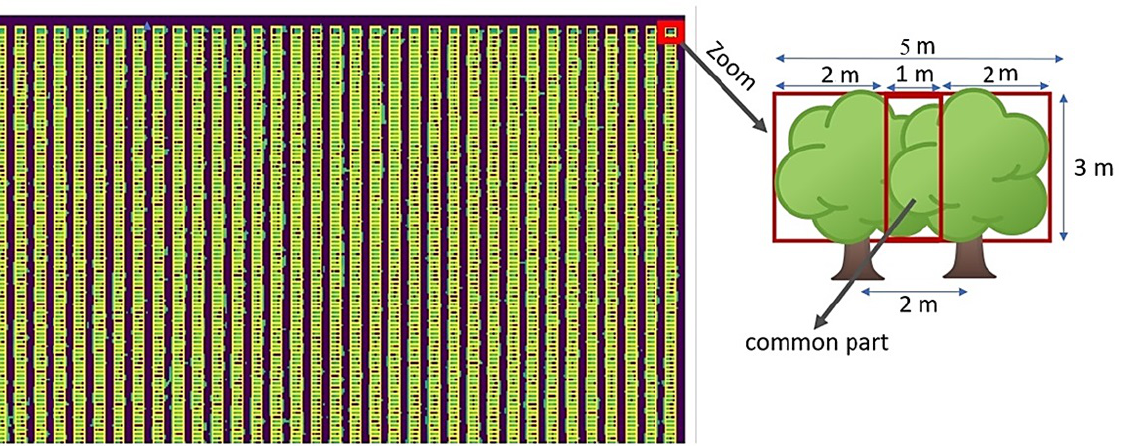
Figure 8. Tree crown detection using the boxes distribution in the